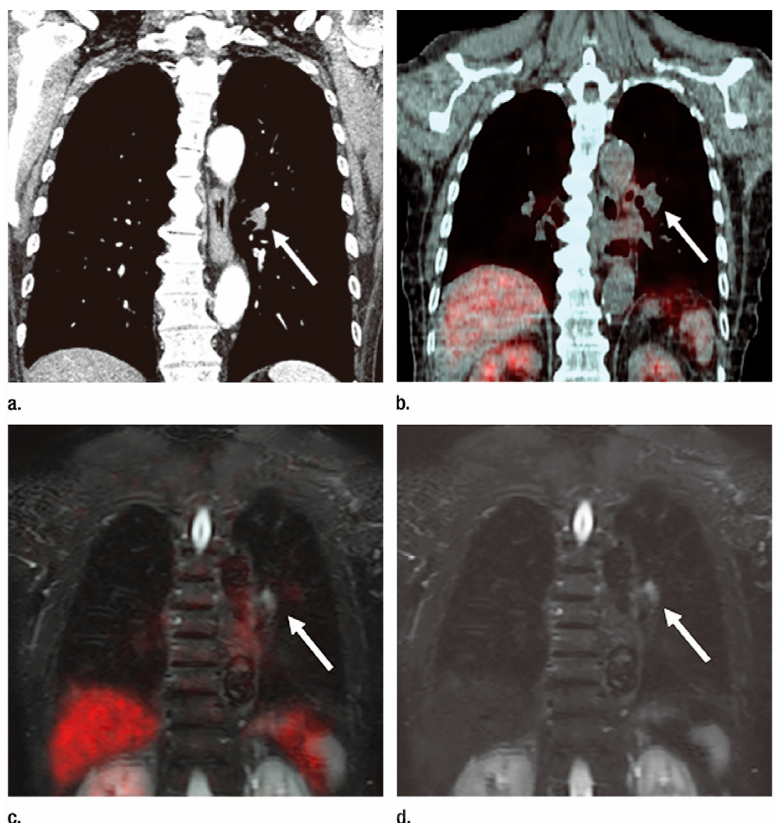
Figure 4. Invasive adenocarcinoma diagnosed as T1bN1M0 and evaluated as stage IIA in a 78-year- old man (permission obtained from reference #59). ( a ) Contrast-enhanced thin-section multiplanar reformatted image shows lymphadenopathy (arrow) with an 8-mm short-axis diameter in the left hilum. This lymph node was diagnosed as nonmetastatic with contrast-enhanced CT imaging; the patient was diagnosed inaccurately. ( b ) Integrated FDG PET/CT image with mediastinal window setting shows a lymph node without high FDG uptake (arrow). This patient was assessed with PET/CT imaging and was classified as T1bN0M0 and stage IA and thus not accurately evaluated with PET/CT imaging. ( c ) Co-registered PET/MR image, which combines FDG uptake with STIR FASE imaging, shows the left hilar lymph node (arrow) with high signal intensity (SI) and a minor amount of FDG uptake. When assessed with SI, this lymph node was diagnosed as metastatic. This patient was therefore diagnosed as T1bN1M0 and stage IIA and accurately assessed by using whole-body PET/MRI with SI assessment. However, when this abnormal SI was not included in the evaluation, whole-body PET/MRI without signal intensity assessment diagnosed this patient as T1bN0M0 and clinical stage IA. This patient could thus not be accurately evaluated by PET/MRI without signal intensity assessment. ( d ) Whole-body MR image obtained by using STIR FASE sequence displays the left hilar lymph node (arrow) with high signal intensity, and it was definitely diagnosed as metastatic. Therefore, this patient was diagnosed as T1bN1M0 and stage IIA and accurately evaluated by using whole-body